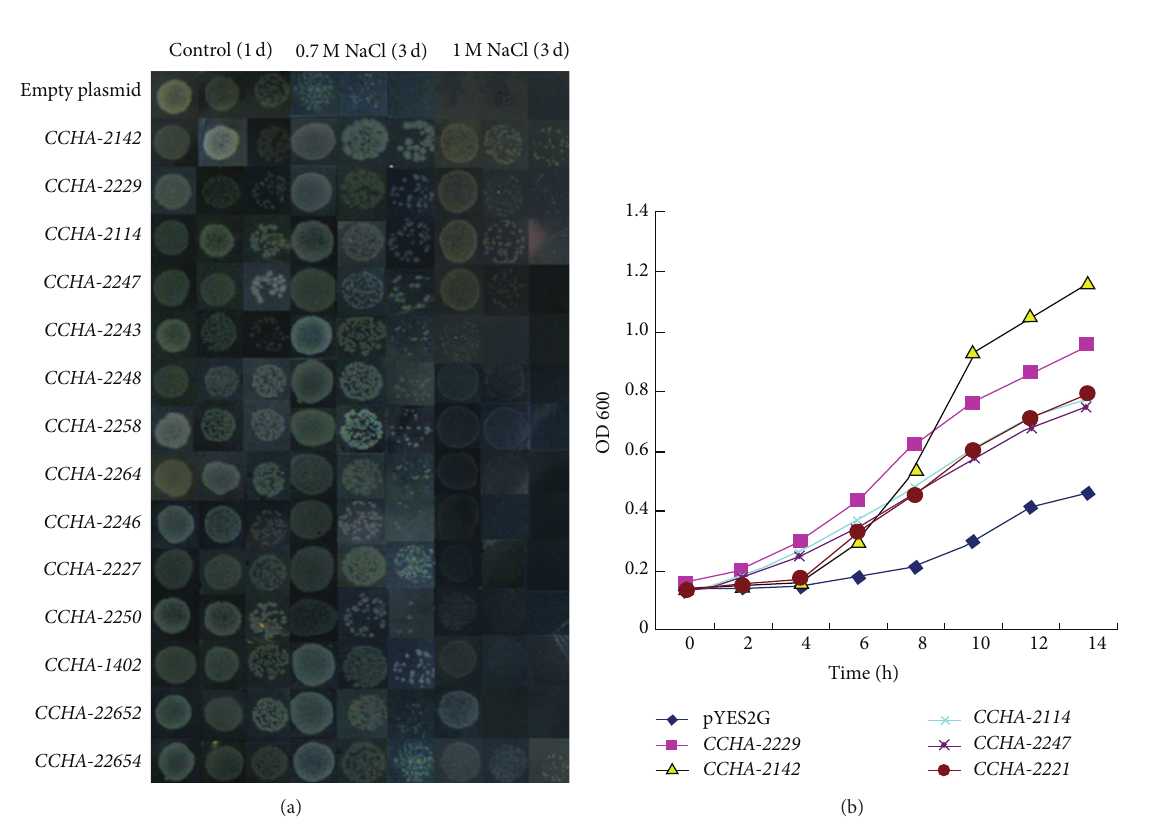
Figure 1: A. glaucus genes confer salt tolerance to E. coli . (a) Spot assay of BL21/pYES2G (empty plasmid), BL21/CCHA-2142, BL21/CCHA- 2229, BL21/CCHA-2114, BL21/CCHA-2247, BL21/CCHA-2243, BL21/CCHA-2248, BL21/CCHA-2258, BL21/CCHA-2264, BL21/CCHA-2246, BL21/CCHA-2227, BL21/CCHA-2250, BL21/CCHA-1402, BL21/CCHA-22652, and BL21/CCHA-22654 on LB plates with 0.7 M NaCl and 1M NaCl. (b) Growth analysis of CCHA-2142 , CCHA-2114 , CCHA-2229 , CCHA-2227 , and CCHA-2247 in LB liquid medium with 1M NaCl. OD 600 was recorded every